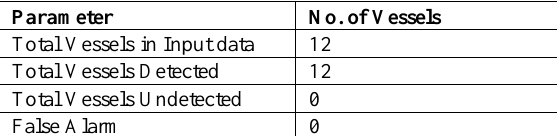
Table 8 UAVSAR Vessels detection rate